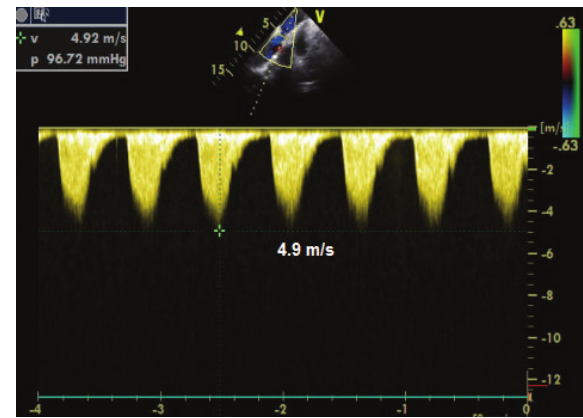
Figure 1: Transthoracic echocardiography showed narrowing of the descending aorta; diameter of the aortic arch was 10.60 mm.